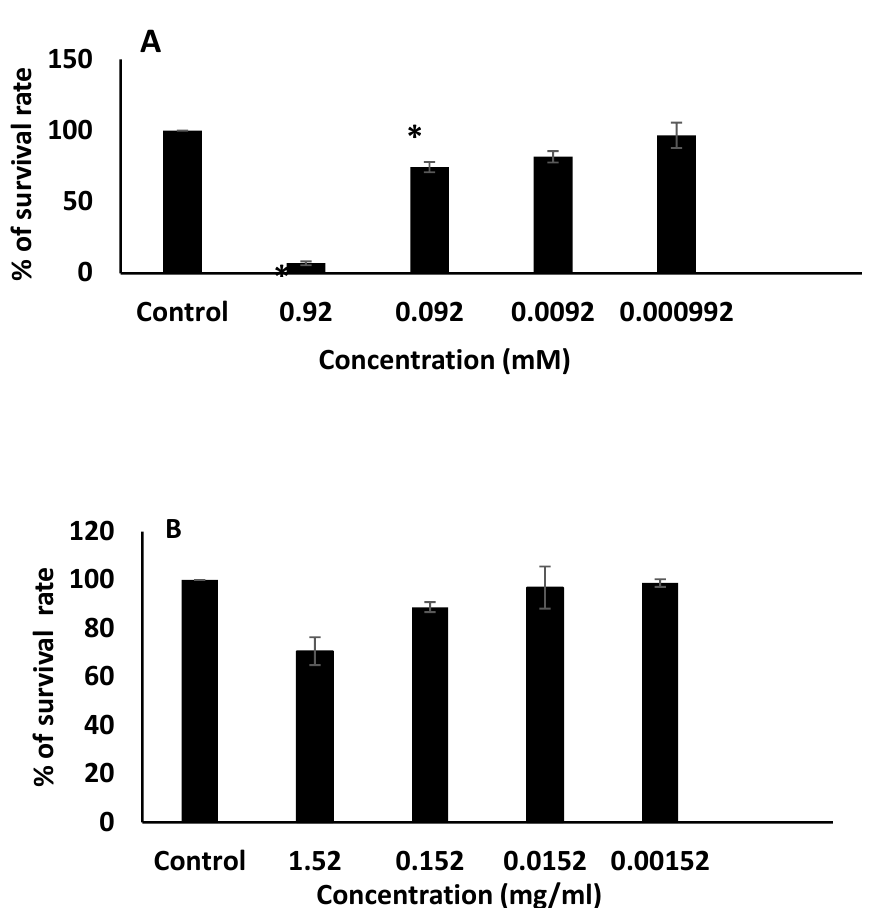
Figure 7. The cytotoxicity of ( A ) F4 and ( B ) blank F4 was evaluated by MTT assay. Each column represents the mean value ± SD ( n = 3). * p < 0.01 indicate significant differences compared to the control